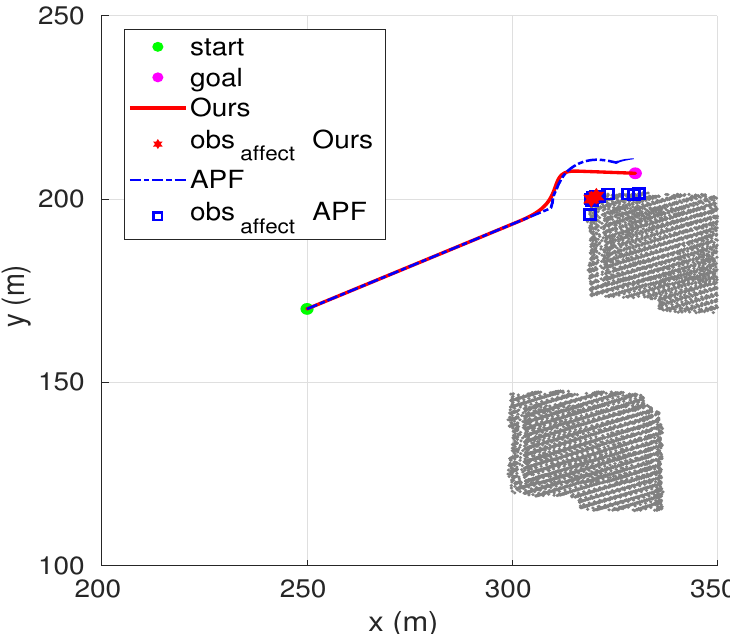
Figure 8. Bird’s eye view of the goal non-reachable with obstacles nearby (GNRON) problem